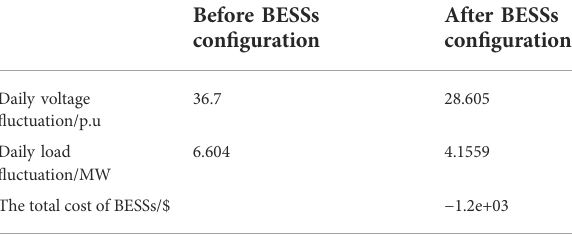
TABLE 6 Comparison before and after BESSs con fi